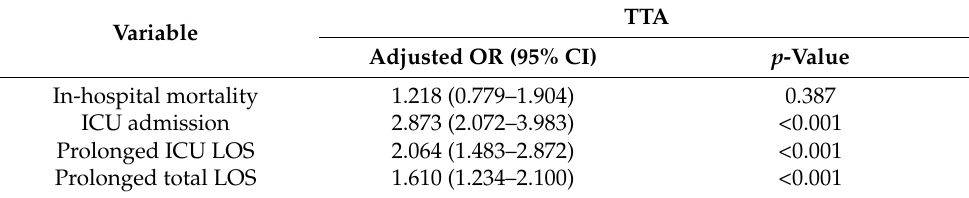
Table 3. Multivariable logistic regression of four major clinical outcomes in TTA groups. Variable